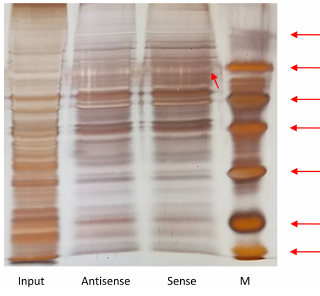
TABLE 6 | Proteinpilot search